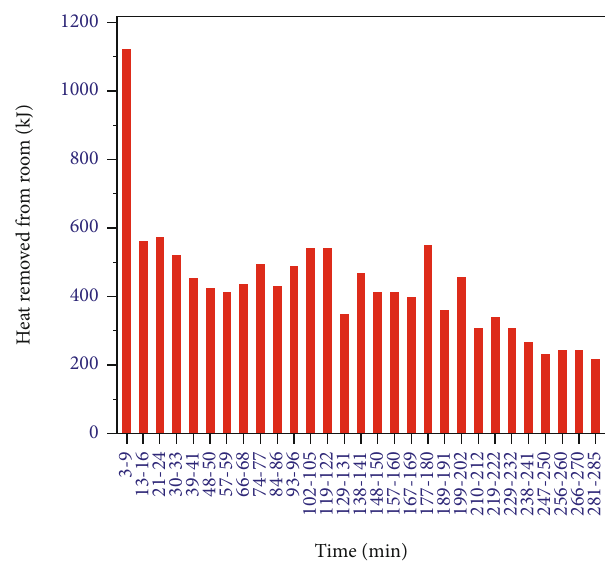
Figure 8: Heat removed from the cabin by HEF during each cycle of